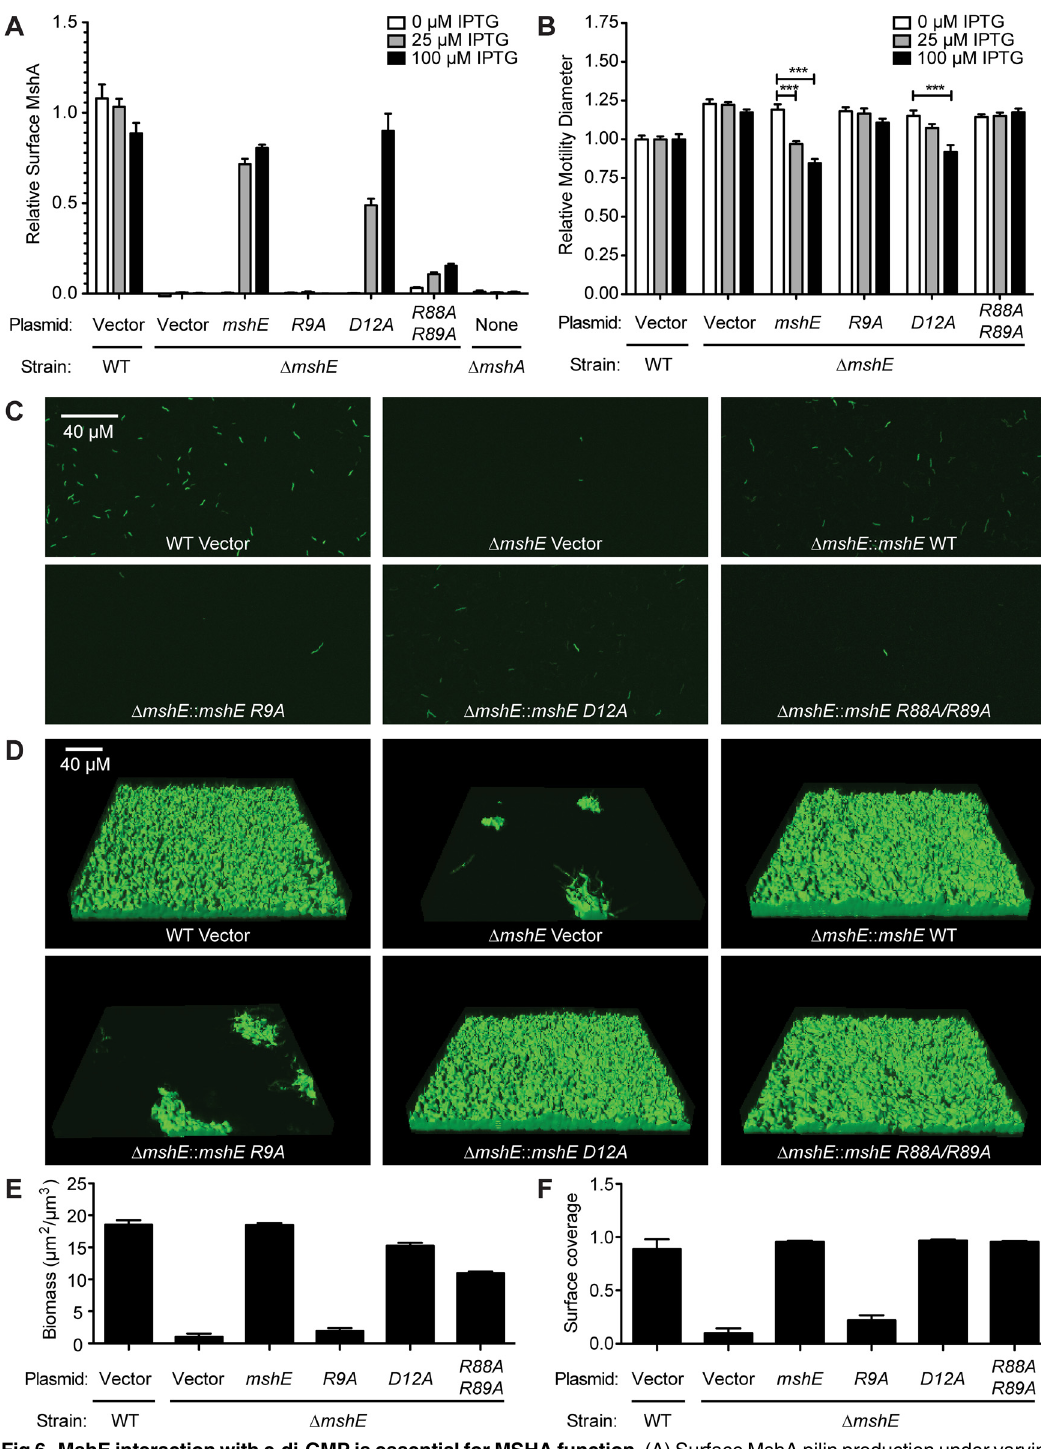
Fig 6. MshE interaction with c-di-GMP is essential for MSHA function. (A) Surface MshA pilin production under varying IPTG induction determined via ELISA with MshA-specific antibody. Two biological replicates were assayed in duplicate and normalized to the average of the WT strain with vector. (B) Expression of mshE reduces motility in soft agar. The diameters of migration zones were measured after 16 hours of growth at 30°C with or without IPTG induction and normalized to the motility of the WT strain harboring the empty vector. Three biological replicates were performed in duplicate. Induced strains were compared to uninduced strains with ANOVA followed by Bonferroni Multiple Comparison test. ( ** p (cid:1) 0.01, *** p (cid:1) 0.001). (C) Attachment phenotypes observed with confocal microscopy 4 h post inoculation in a flow cell system. Scale bar represents 40 μ m. (D) Three-dimensional biofilm structures observed